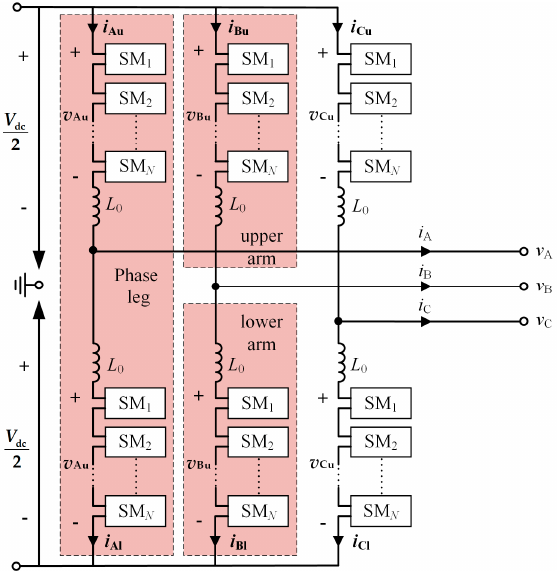
Figure 1. The topology of the modular multilevel converter (MMC).